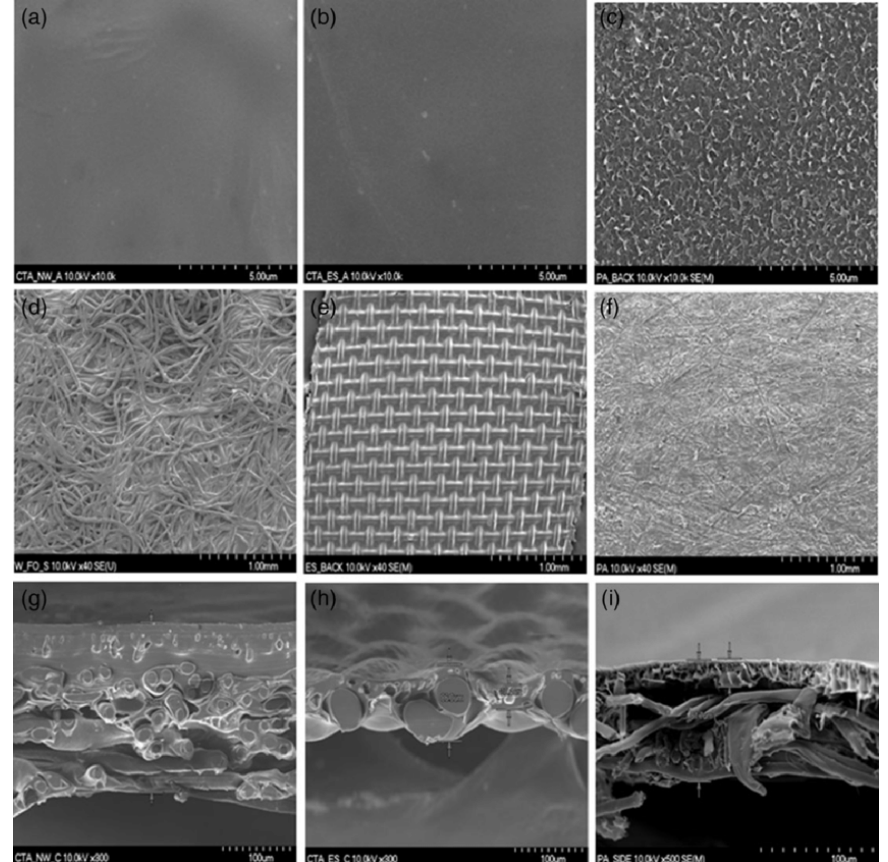
Figure 6. SEM images of surface active side ( a ) CTA non-woven (NW), ( b ) CTA embedded support (ES,) and ( c ) Polyamide (PA) surface support layer ( d ) CTA NW, ( e ) CTA ES, and ( f ) PA, cross section ( g ) CTA NW, ( h ) CTA ES, and ( i ) PA. Reprinted figure with permission from [70]. Copyright (2016) Wiley.